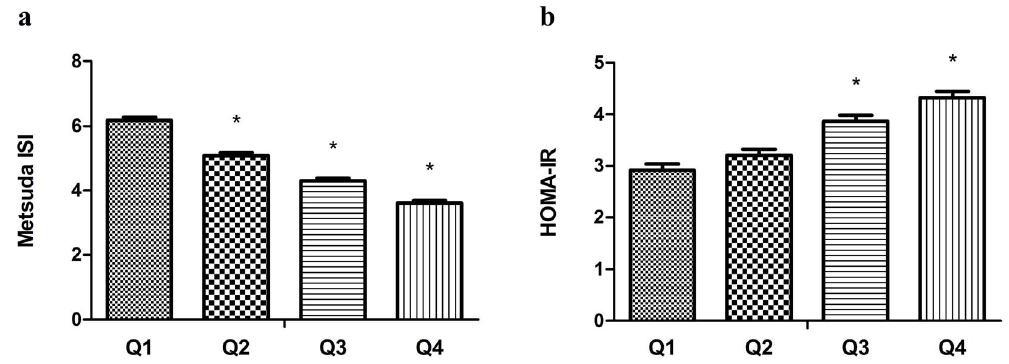
Figure 3. Matsuda ISI (mean ± s.e.) and HOMA-IR (mean ± s.e.) according to visceral adiposity index quartiles after adjustments for sex and age. * P , 0.001 for the comparison to the first quartile. Matsuda ISI, Matsuda Insulin Sensitivity Index; HOMA-IR, homeostasis